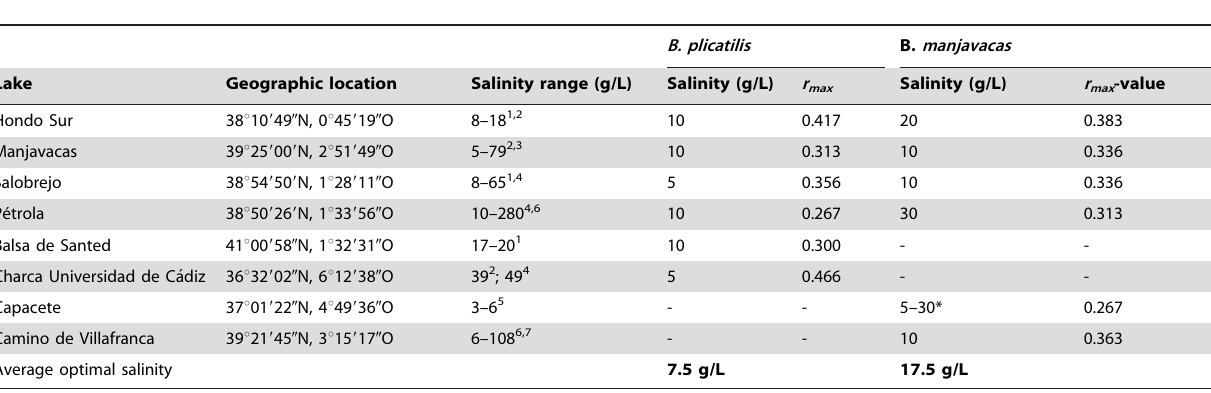
Table 1. Lake information, maximum growth rates and optimal